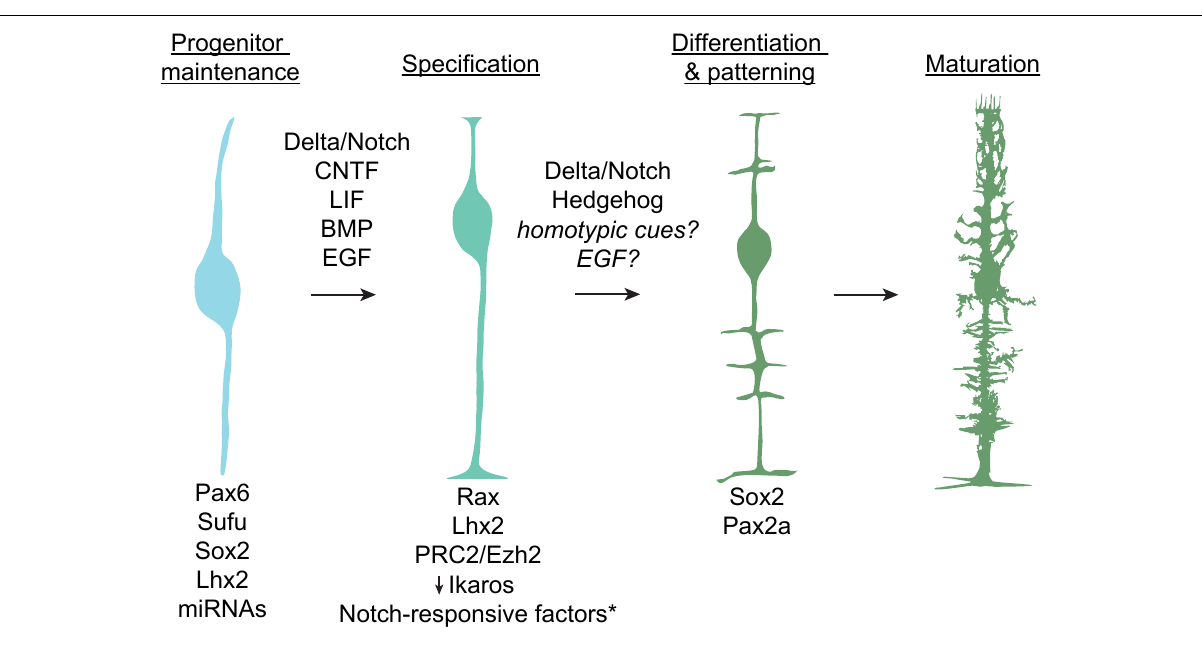
involved in cell growth and proliferation (Goureau et al.,